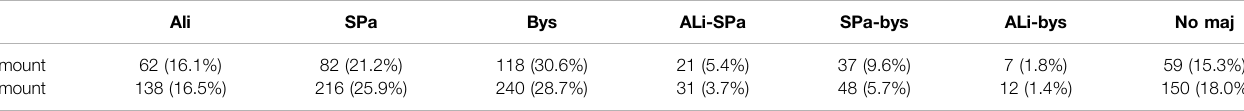
TABLE 1 | The fi rst row of this table states the number of samples per listener categories (LCategory), in absolute numbers and percentages, as originally reported in Oertel et al. (2015). The second row of this table states the numbers as used in this article. It can be observed that the number of samples got more than doubled and that in 82.0% of cases, a majority annotation was reached. Ties occurred mainly between neighboring categories such as ALi-SPa and SPa-Bys, as opposed to further away categories such as ALi-Bys. Ali